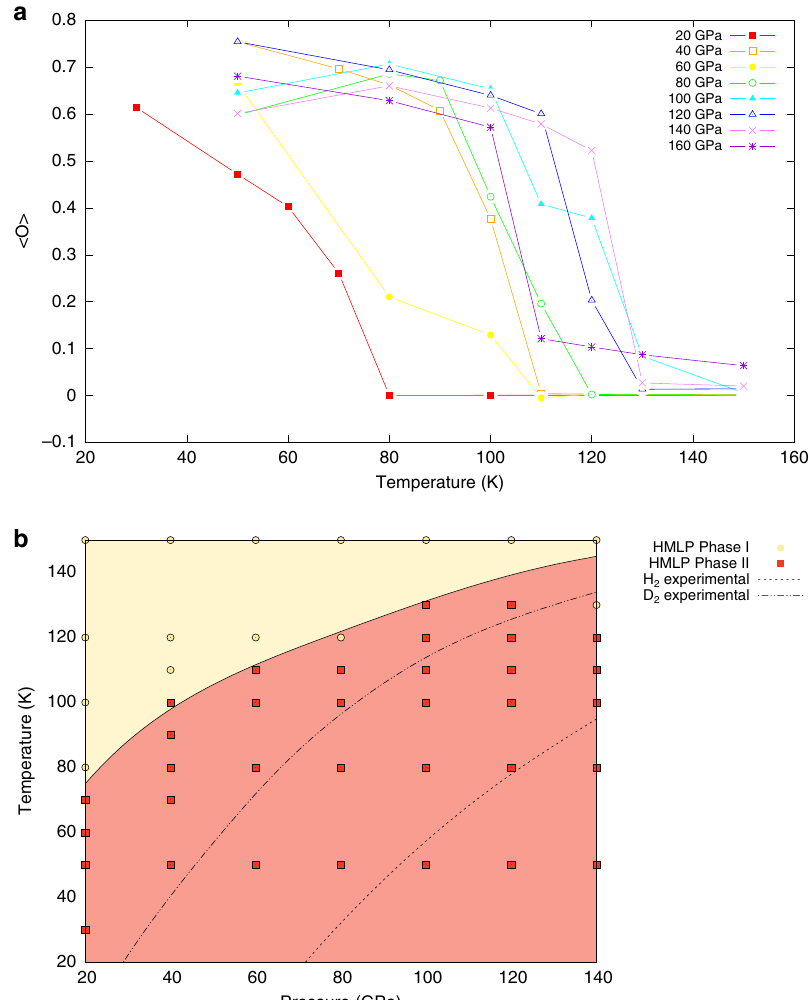
Fig. 6 Order parameter and phase boundary for the I – II transition. a Order parameter h O i as a function of temperature for the seven pressures investigated in this work. In all cases there is a sharp decrease from an ordered system ( h O i ¼ 1) to a disordered system ( h O i ¼ 0). The system is considered to be Phase I after h O i drops discontinuously below 0.1. b The resultant phase boundary for the I – II transition in the classical solid. The dashed lines represent the experimental phase boundaries for hydrogen and deuterium, respectively 32